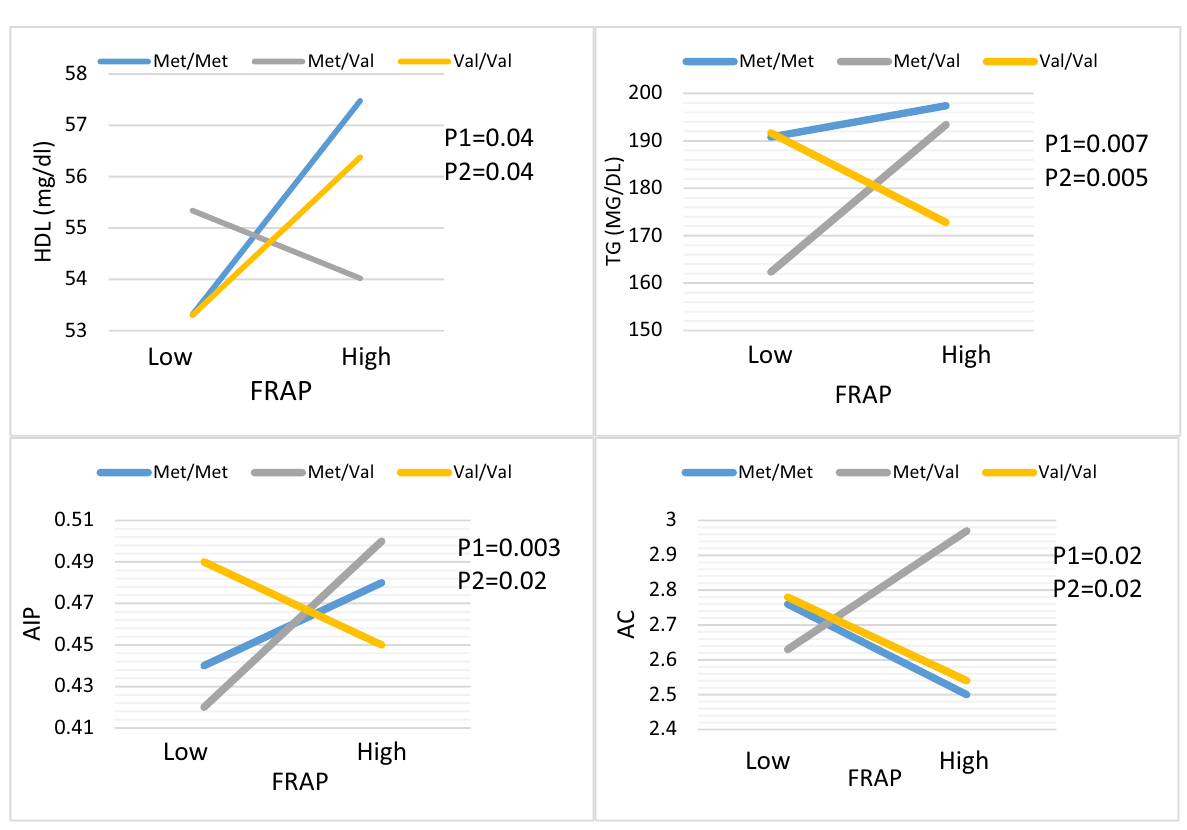
Figure 1. Interaction between the BDNF Val66Met polymorphism and DTAC (FRAP) intake with regard to TG, HDL, AIP and AC according to the median DTAC, the participants were dichotomized into low and high categories. P 1 = P value with unadjusted (crude) model, P 2 = P value with adjustments for potential confounding factors including (Age, physical activity, sex, smoking, alcohol, energy intake, lipid, and glucose- lowering medicines, and family history of